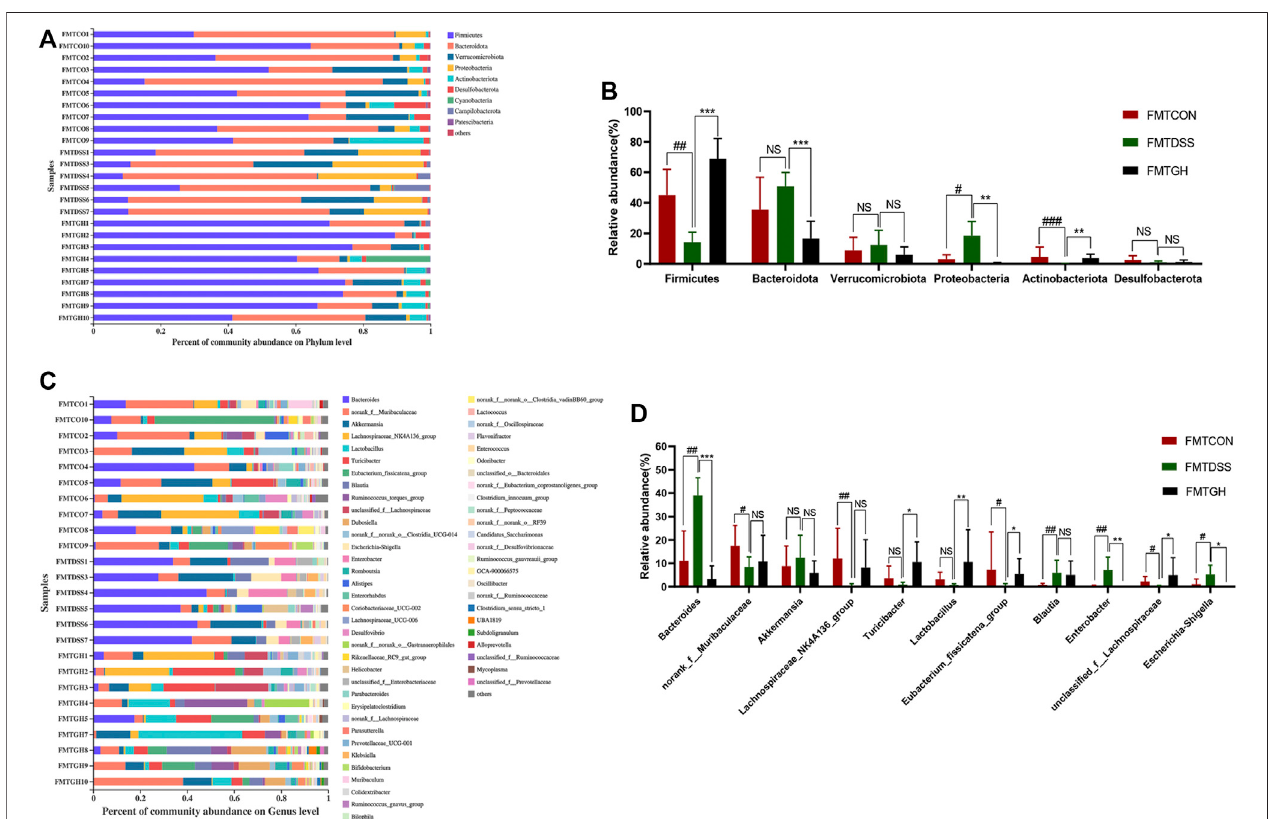
FIGURE 7 | FMT altered the gut microbiota composition among different groups. (A) The bar plot of microbiota compositions at the phylum level among three groupsand (B) Signi fi cantdifferencesintheabundanceofphylawithhighabundance(top6). (C) Thebarplotofmicrobiotacompositionsatthegenuslevelamongthree groups and (D) Signi fi cant differences in the abundance of genus with high abundance (top 11). Data were expressed as mean ± SD (n (cid:2) 6 – 10). # p < 0.05, ## p < 0.01, ### p < 0.001, vs FMTCON group; * p < 0.05, ** p < 0.01, *** p < 0.001 versus the FMTDSS group. NS means no statistical signi fi